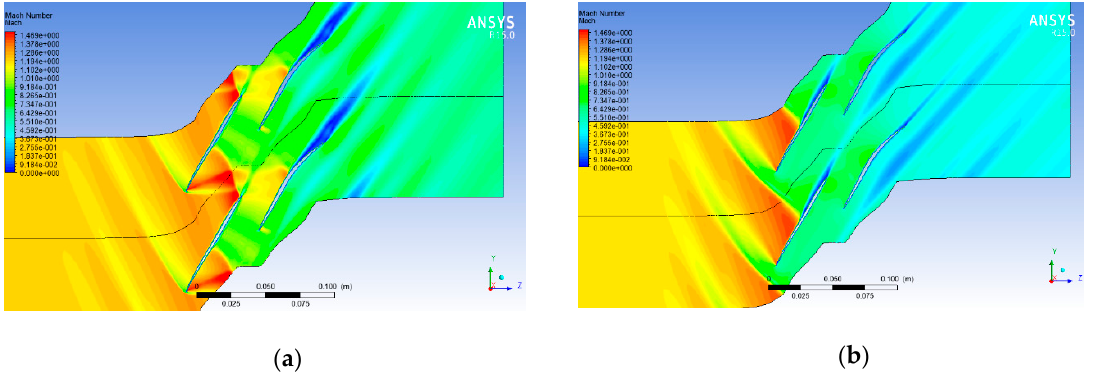
Figure 11. Comparison of the basic and optimized blade di ff usion factors. ( a ) Di ff usion factor of the tandem blade, ( b ) Di ff usion factor of the single blade.